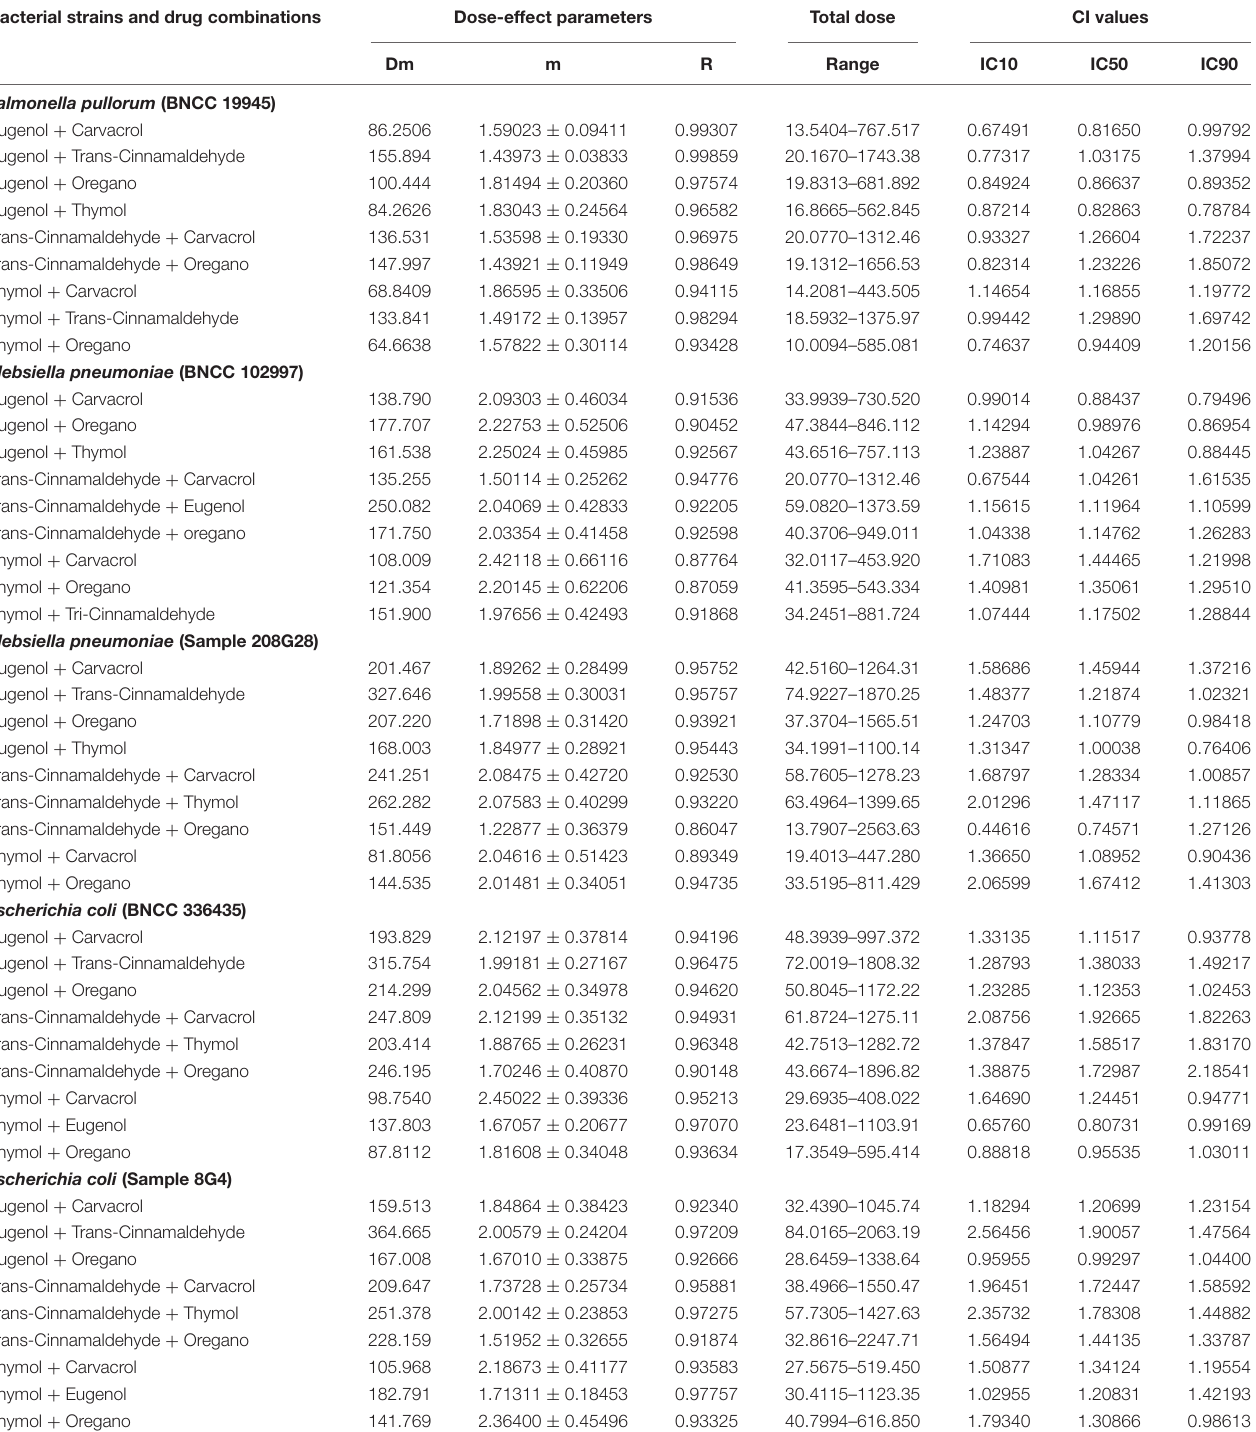
TABLE 2 | Dose-effect relationship parameters and mean combination index (CI) values of drug combinations for bacterial strains. Bacterial strains and drug combinations Dose-effect